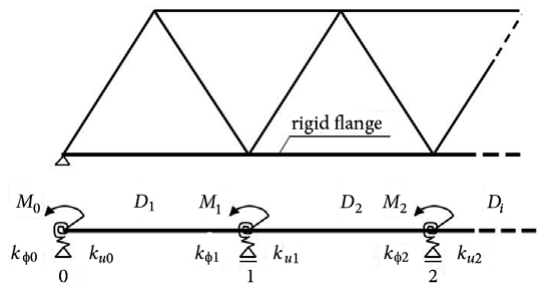
Fig. 3. Computational model for the stage II of analysis